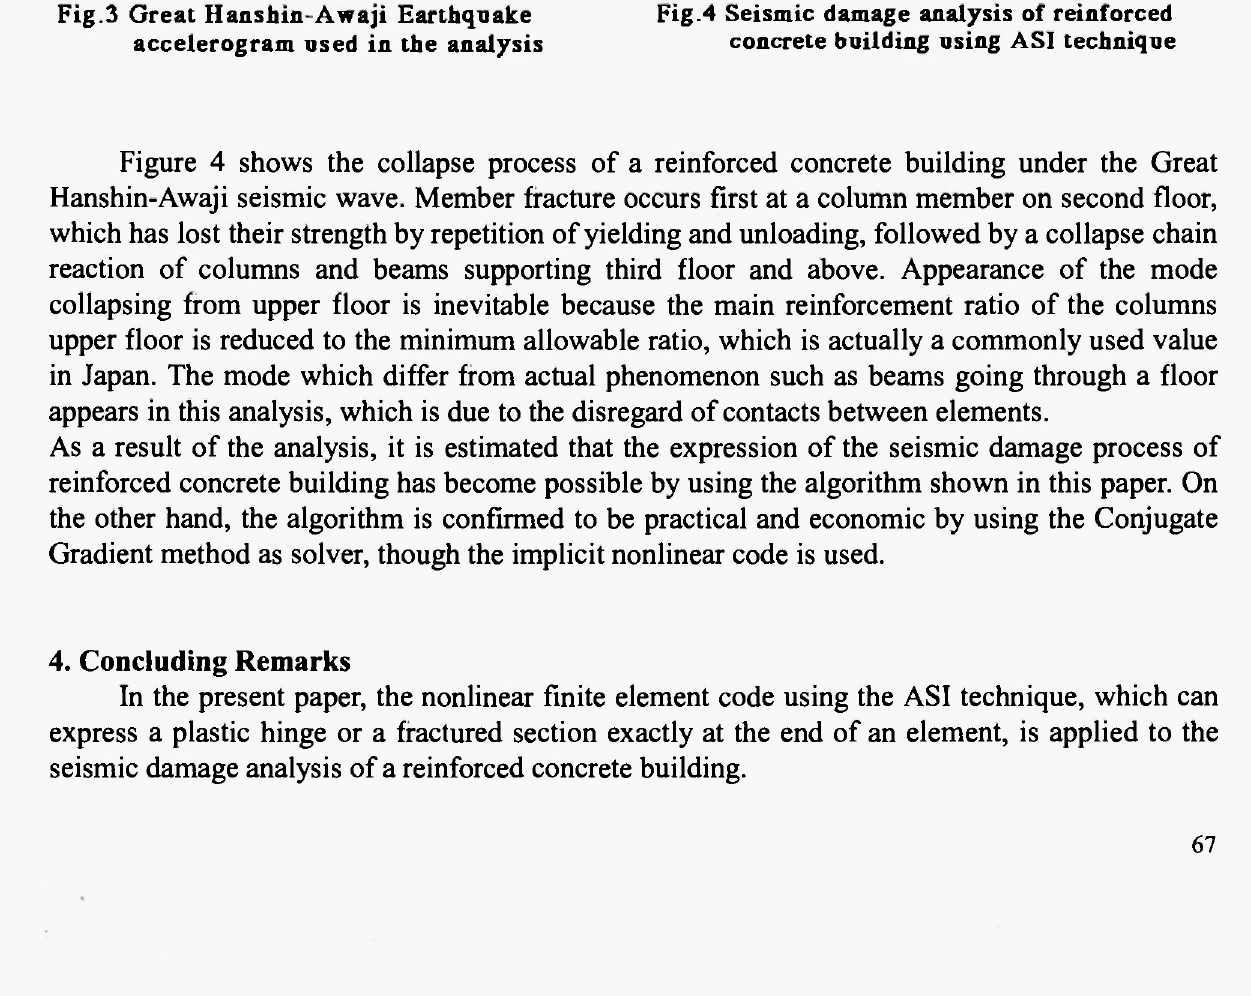
Fig.3 Great Hanshin-Awaji Earthquake accelerogram used in the analysis